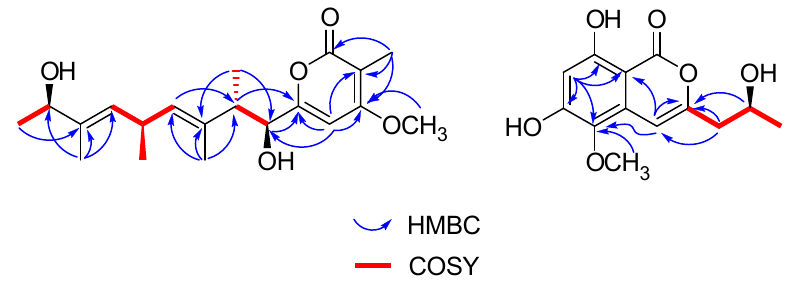
Figure 2. Key HMBC, 1 H- 1 H COSY correlations of 1 and 2.